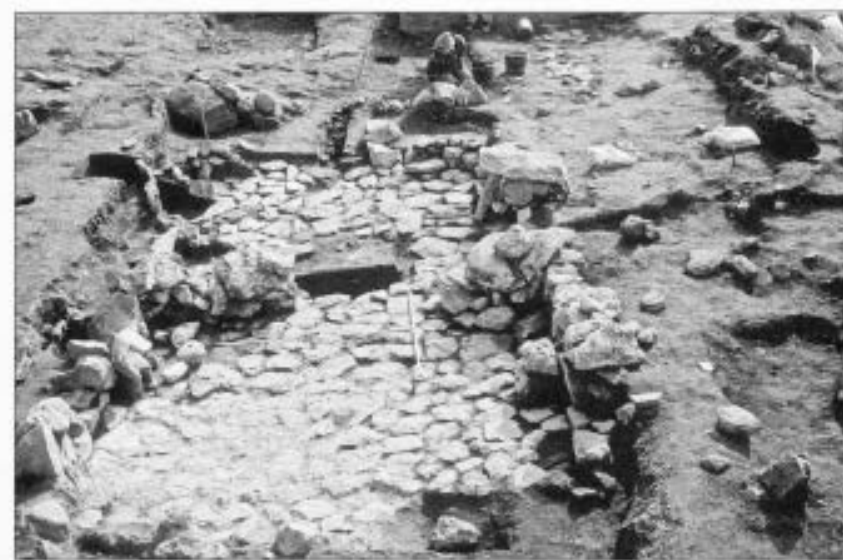
Figure 7 The foundations of the putative bath-house, looking east, before the (steam?) conduit was excavated. hollowed-out pinewood pipes. There are